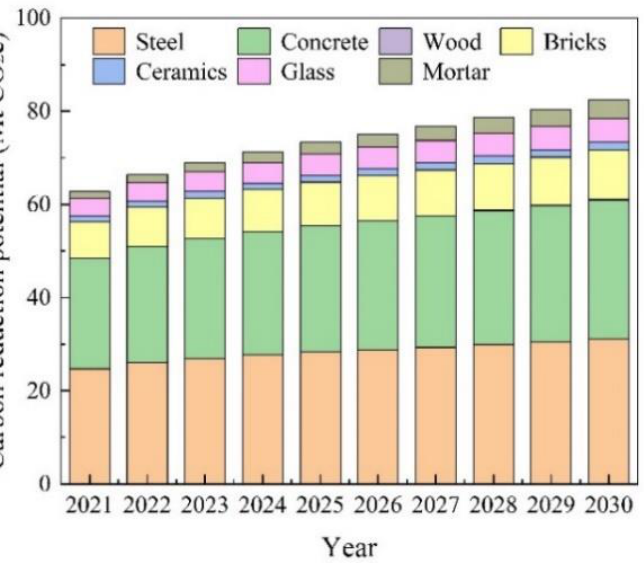
Figure 9. The annual carbon reduction potential of recycling CDRW in Jiangsu Province from 2021 to 2030.